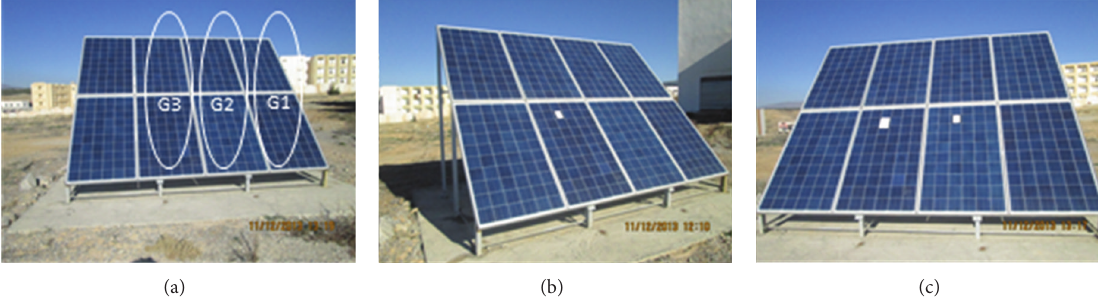
Figure 6: Structure of a PV string and the partial shading in each group.